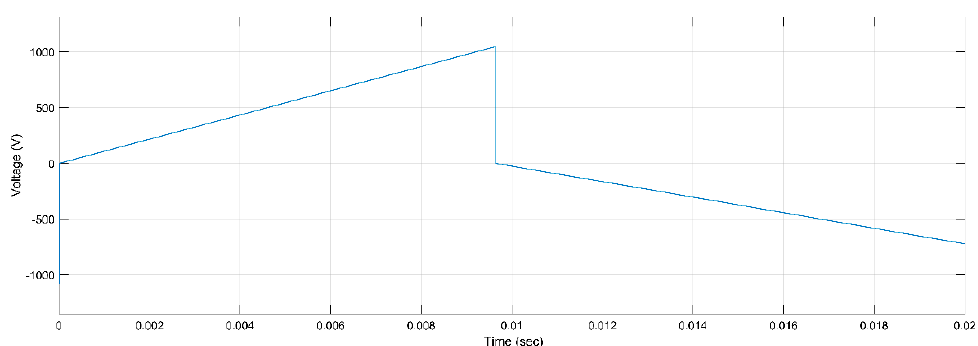
Figure 29. PD Activity for Combination, 5 kV, h, r.